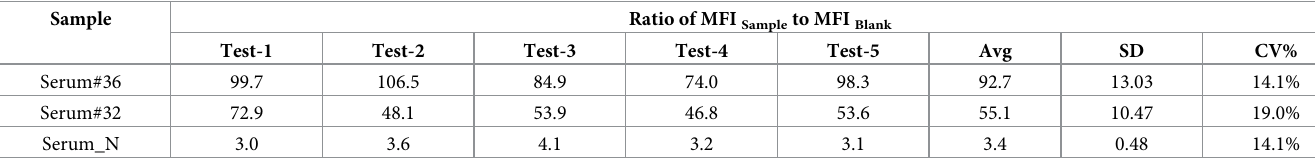
Table 5. Inter-assay reproducibility. Sample Ratio of MFI Sample to MFI